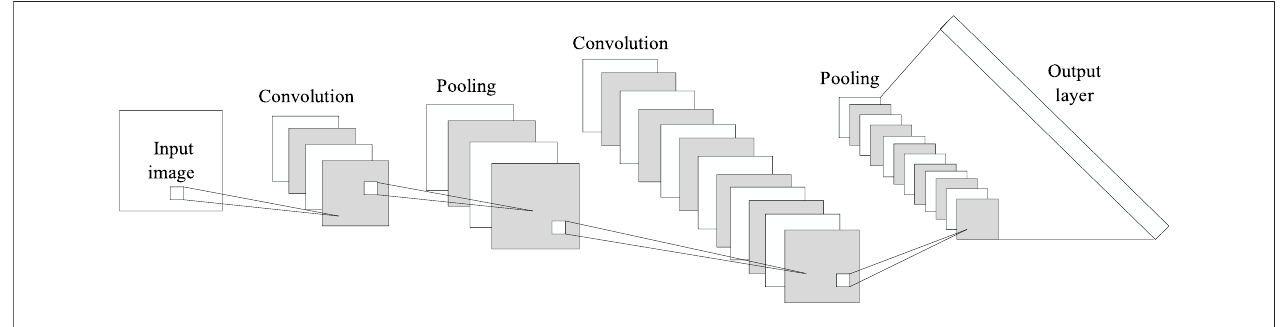
FIGURE 2 | Structure of standard convolutional neural network.